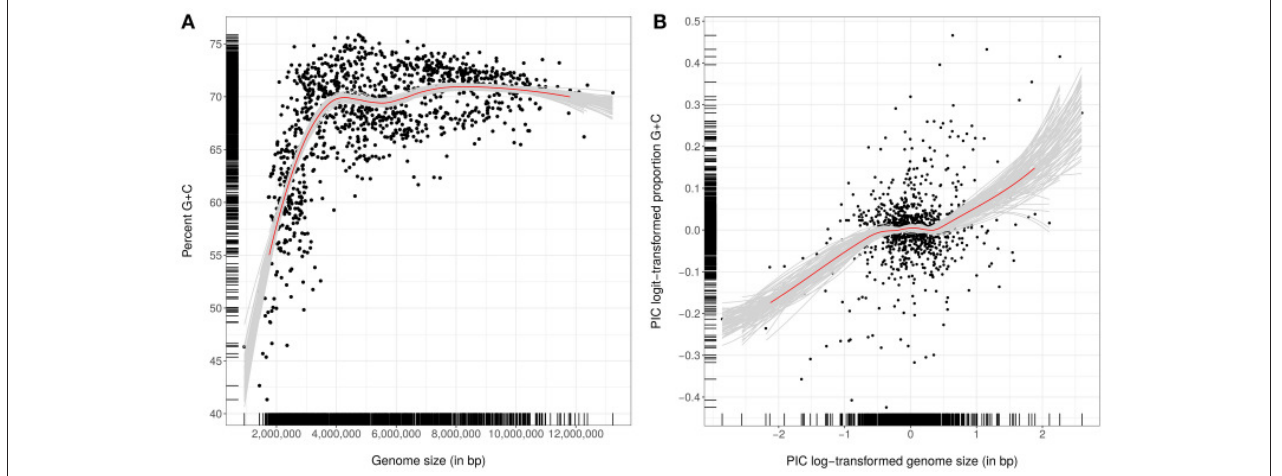
FIGURE 9 | (A) Percent G + C content in dependence on genome size (in numbers of base pairs). (B) Phylogenetically independent contrasts (PICs) derived from logit-transformed proportions of G + C content in dependence on PICs derived from log-transformed genome sizes. PICs were calculated to account for the significant effect of the phylogeny on both G + C content and genome size. In both panels, Loess-based bootstrap aggregation (100 replicates) was applied; the resulting red curve denotes the average from 100 smoothers, each fitted to a subset of the original data set, to increase stability and reduce overfitting.